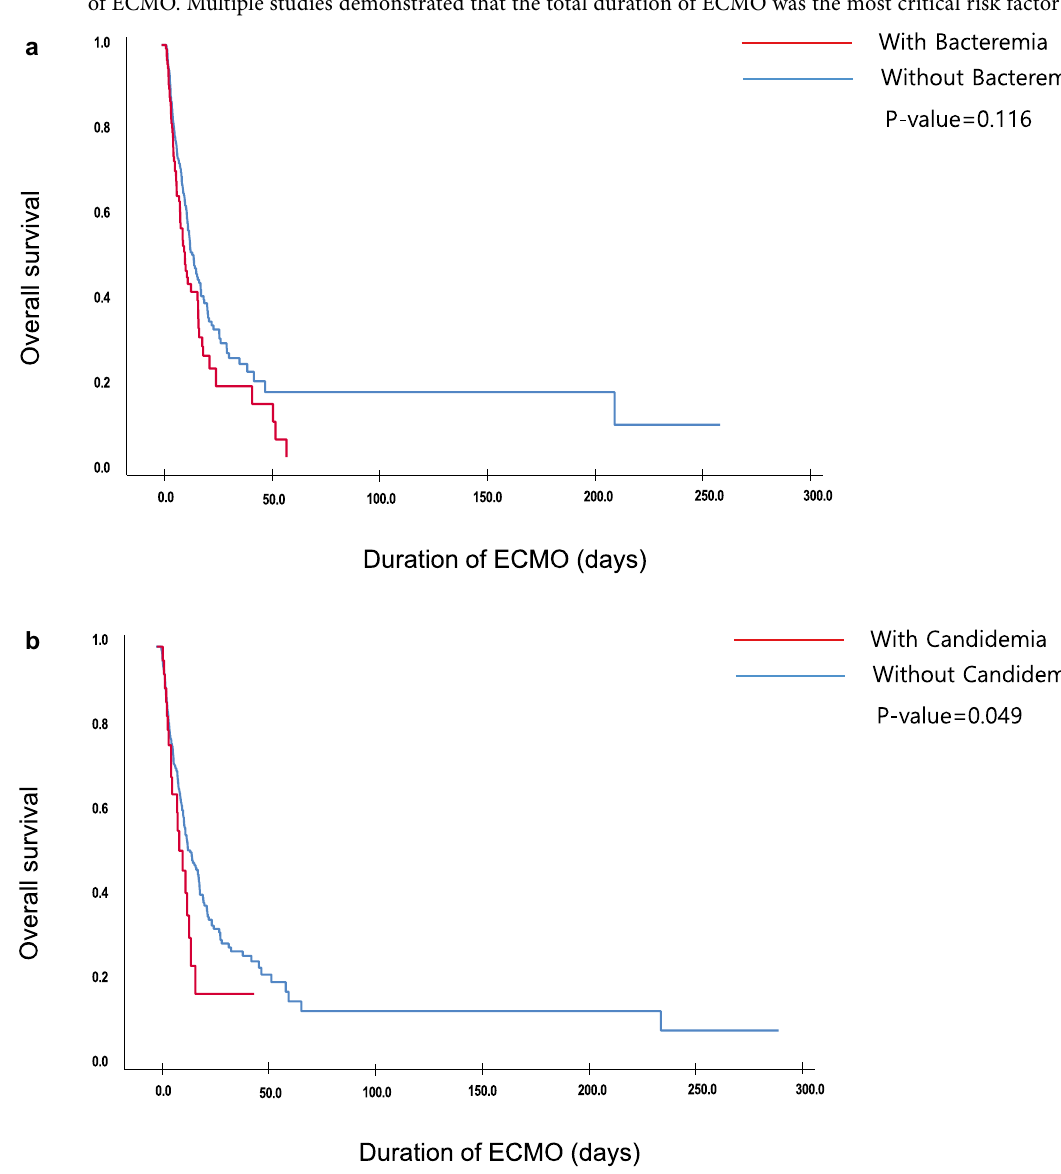
Table 2. Clinical variables associated with bloodstream infection (bacteremia, candidemia). p values with statistical significance is shown in italics text. *Indicates bacteremia group. † Indicates candidemia group. BMI body-mass index, COPD chronic obstructive pulmonary disease, ECMO extracorporeal membrane oxygenation, VA veno-arterial, VV veno-venous, VAV veno-arterial-venous, PLS prolonged life support, EBS emergency bypass system.